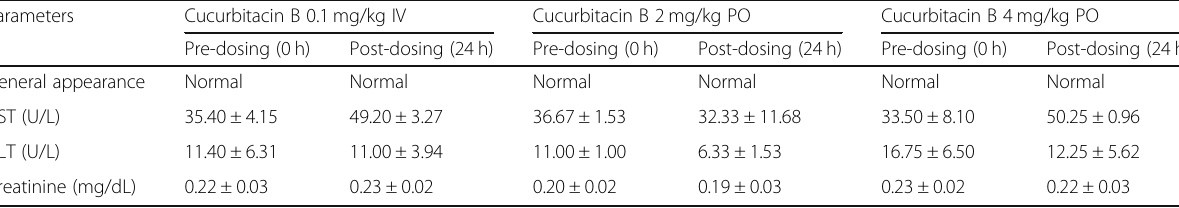
Table 5 General appearance and biochemical markers indicating liver and kidney functions before and after cucurbitacin B treatment